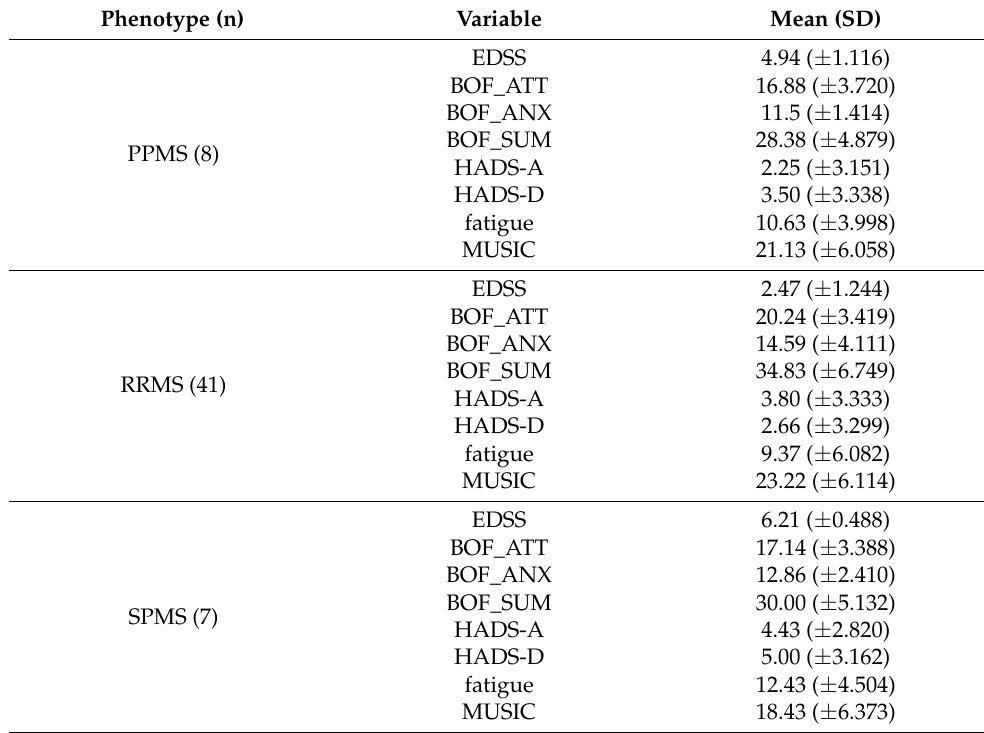
Table 3. Descriptive Statistics of Demographic and Clinical Variables sorted by phenotype (N =